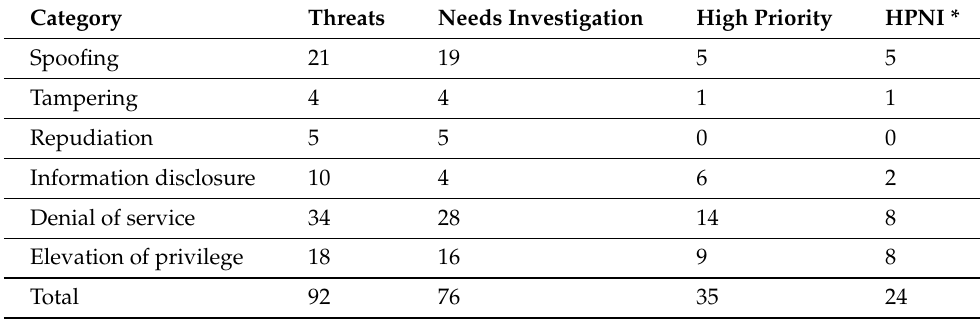
Table 2. Threat modeling results from both